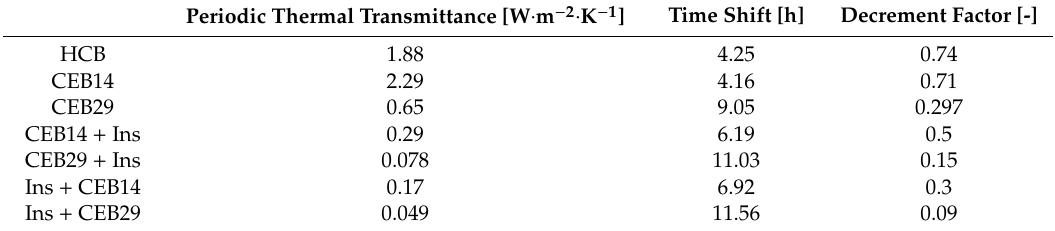
Figure 4. Constructive systems of the walls. Table 2. Dynamic thermal characteristics of walls.